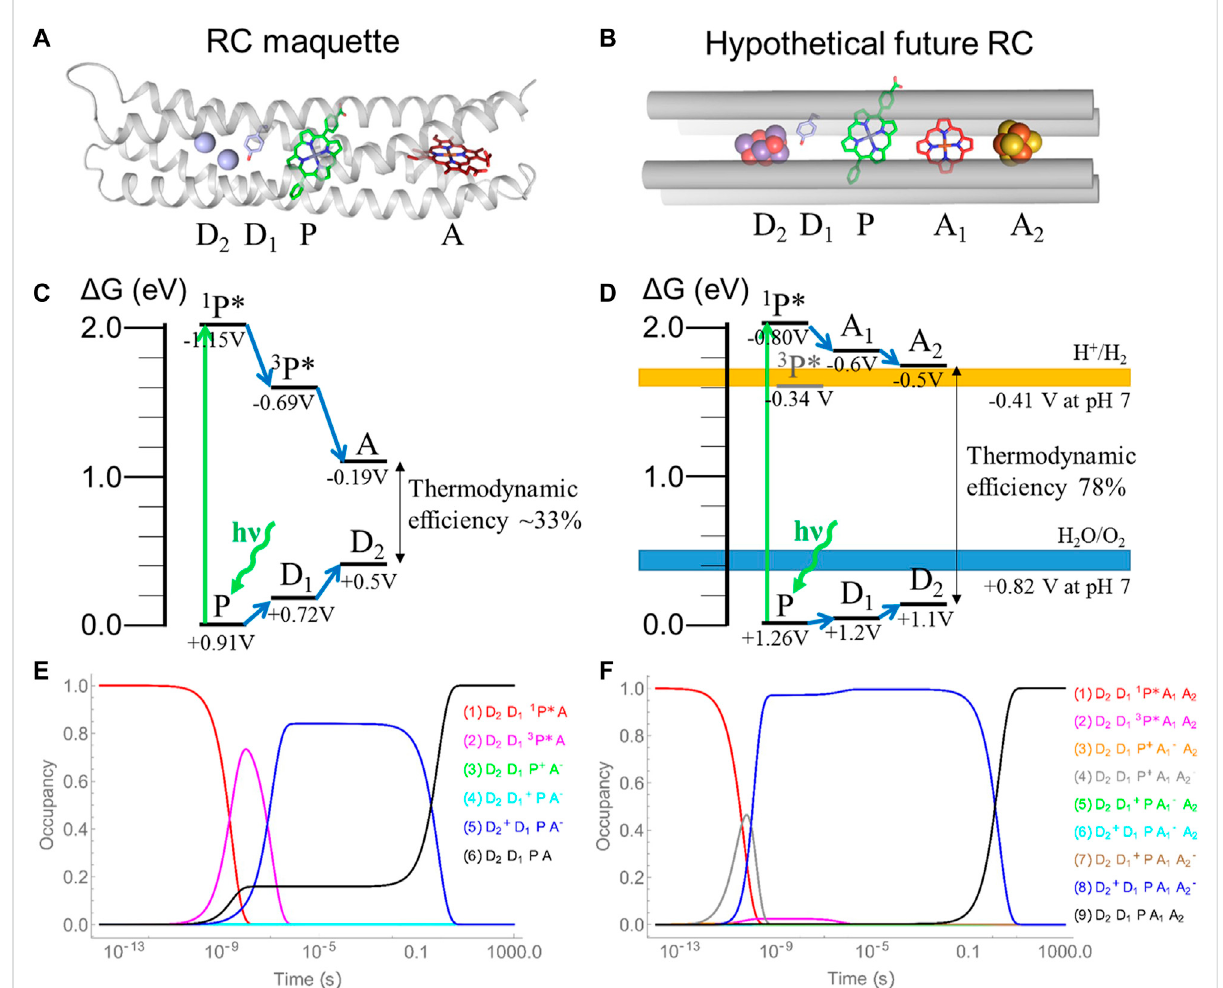
FIGURE 10 Comparison ofRCmaquette tetradandhypotheticalpentad design. (A) Amodel oftheRCmaquettetetradwithironions astheelectron donor D 2 , a tyrosinate side chain as donor D 1 , Zn-5-(carboxyphenyl)-15-phenyl-porphyrin (ZnPCP) as the pigment P, and heme B as the electron acceptor A. (B) A diagram of a proposed pentad using a Mn 4 Ca cluster (similar to the OEC in PSII) as D 2 , tyrosine as D 1 , ZnPCP as P, a tetrapyrrole as A 1 , and an iron sulfur cluster as A 2 . (C) Energy level diagram of the RC maquette tetrad depicted in panel (A) . (D) Energy level diagram of the hypothetical pentad design depicted in panel (B) . (E) Predicted time evolution of the RC maquette tetrad after initial photoexcitation to the 1 P* singlet state. (F) Predicted time evolution of the hypothetical pentad RC after photoexcitation to the 1 P* singlet state. Potentials at which water oxidation and proton reductionoccurareindicatedbyblueandorangebands,respectively.Calculationsinpanels (E , F) arebasedonEq.1anddonotconsiderthepossible effects of changes in spatial distribution of electron density in the triplet state or spin